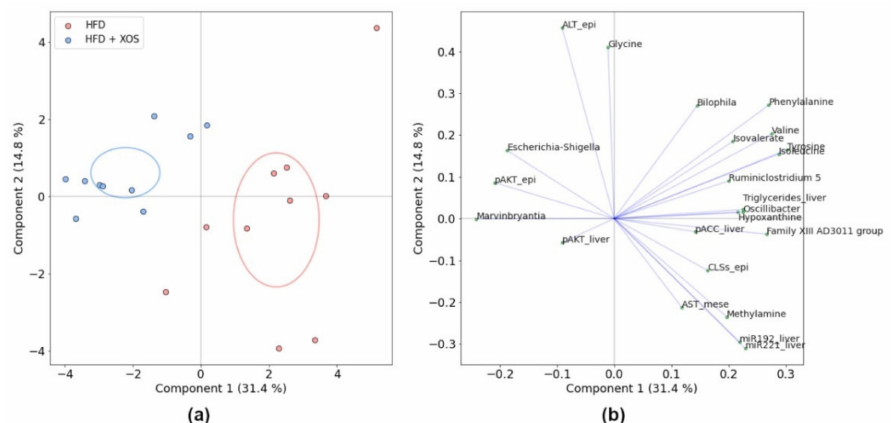
Figure 9. PCA of the HFD and HFD + XOS groups with all significantly differing features and biomarkers, ( a ) Ordination and ( b ) Loading plots. The ellipses indicate 95% confidence intervals. The total explained variance for each component is shown in parentheses. epi = epididymal fat, mese = mesenteric fat.